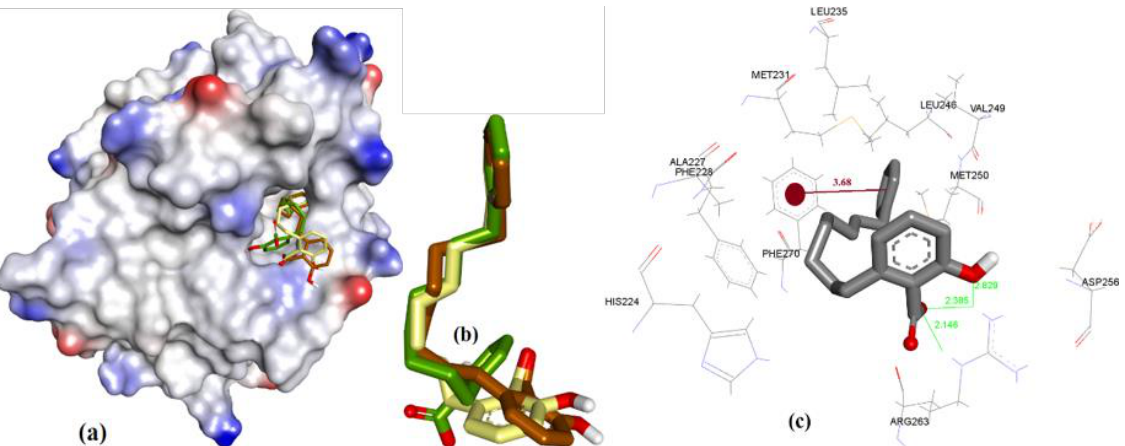
Figure 10. ( a ) The ionized solvent-exposed surface mapping of hMcl-1 along with the docked poses of 3c from MOE (in brown), AutoDock (in green), and VlifeDock (in yellow) show their fitting to the cavity. ( b ) Similar-pose ensemble clustering of all three poses was attained from the three different docking methods. ( c ) Binding mode of 3c .